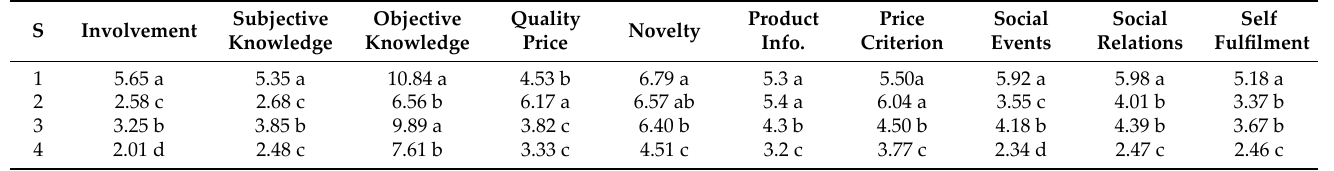
Table 5. Segment identification based on assessed constructs for